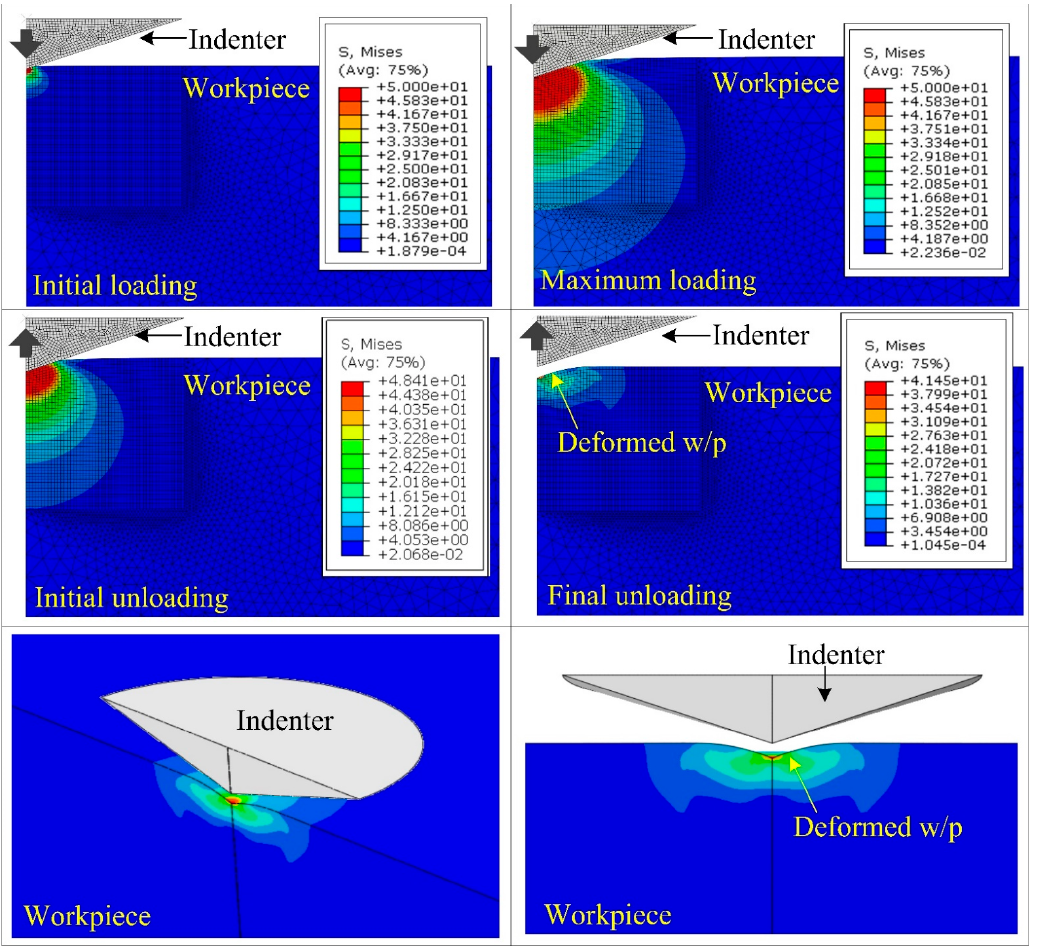
Figure 6. Stress contours to represent nanoindenter behavior for different stages. The LVD curves obtained from experimentation and simulation are represented in Figure 7. The close agreement between experimental and simulation findings demon- strates the FE model’s accuracy in predicting the mechanical characteristics of machined glass material using the ECSM process.